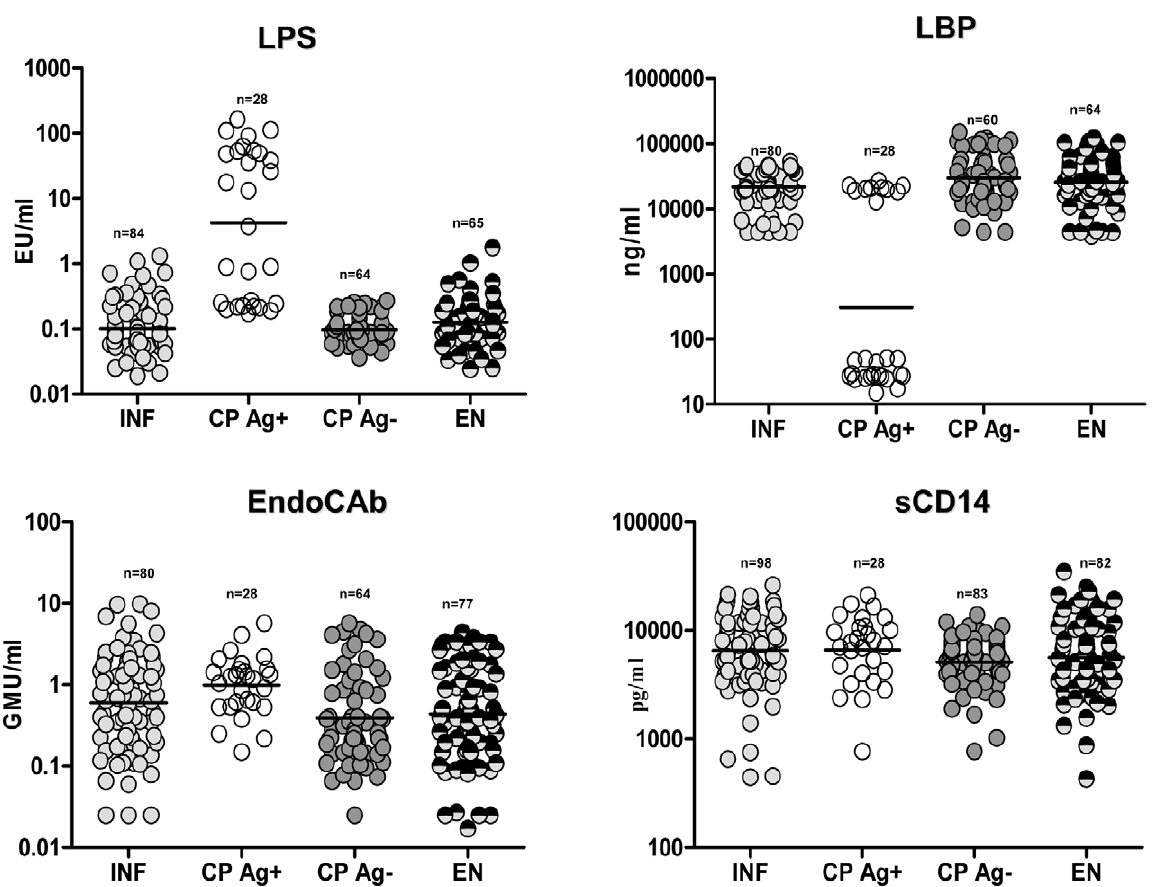
Figure 1. Filarial lymphedema is associated with elevated levels of LPS. Plasma levels of LPS, LBP, EndoCAb and sCD14 from asymptomatic infected [INF] individuals; filarial lymphedema individuals with active infection [CP Ag + ]; filarial lymphedema individuals without active infection [CP Ag 2 ] and endemic normal [EN] individuals were measured by ELISA and immunoassays. Data are shown as scatter plots with the bar representing the geometric mean.